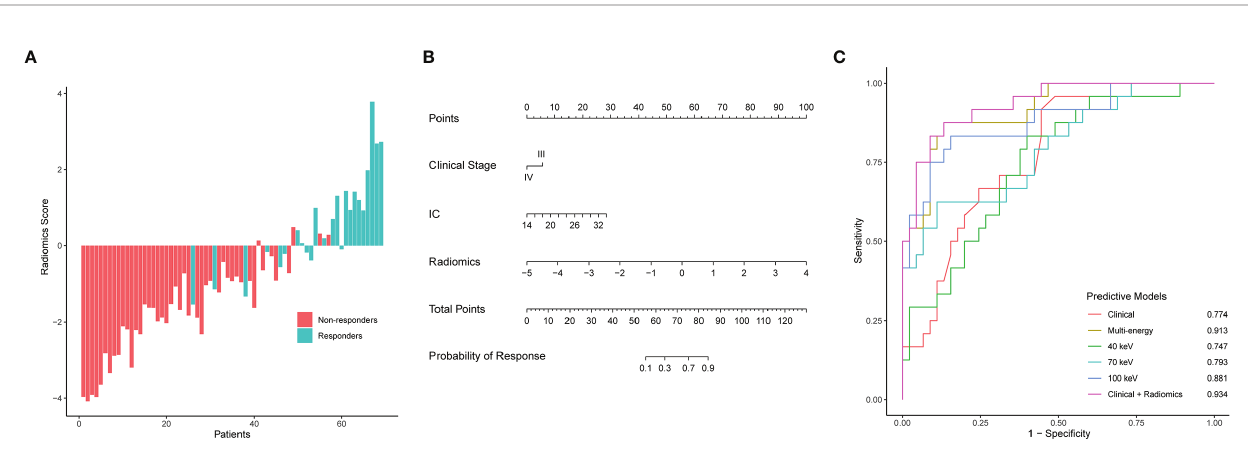
FIGURE 4 | Radiomics score, nomogram developed with the combined model, ROC curve analysis of all models. (A) Waterfall plot for distribution of radiomics scores for each patient. (B) The developed clinical-radiomics nomogram to predict response to chemotherapy in patients with gastric cancer. (C) ROC curves of all models for predicting response to chemotherapy. AUC, area under the curve; Clinical-radiomics ,